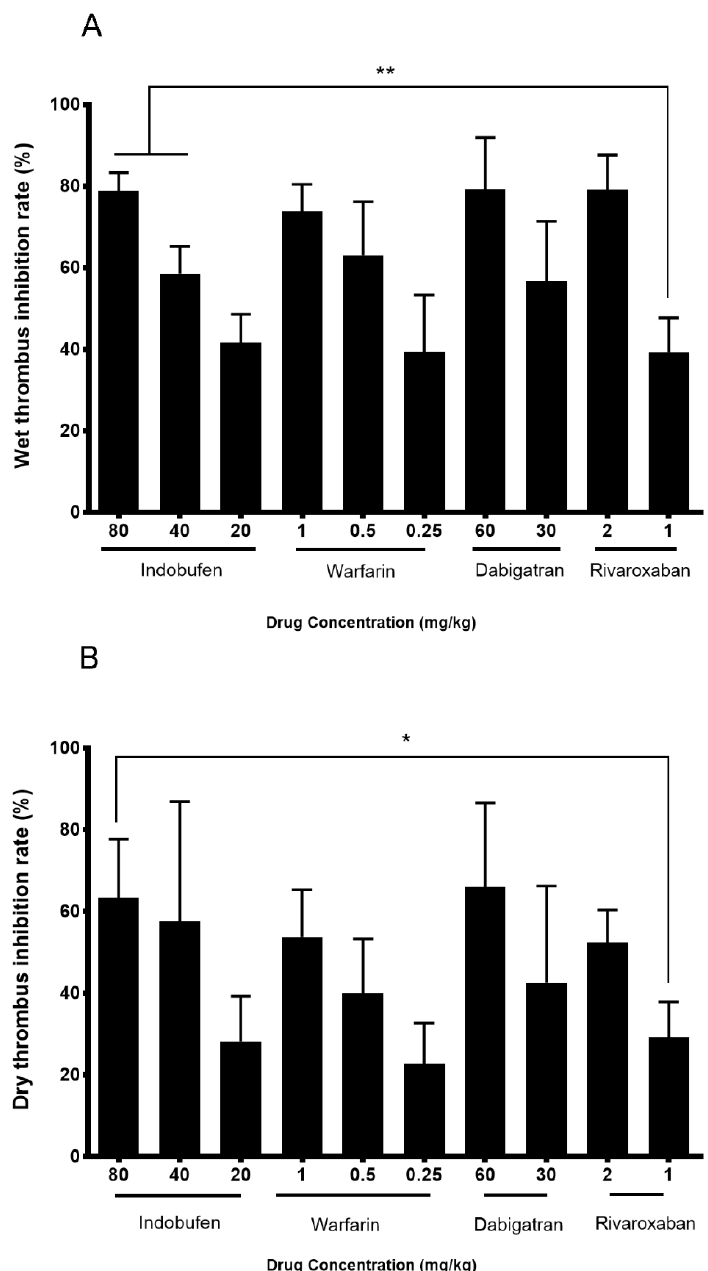
Figure 5. The effects of indobufen on thrombosis formation in a rat model of an arteriovenous shunt. ( A ) The results of wet thrombus inhibition. ( B ) The results of dry thrombus inhibition. * p < 0.05, ** p < 0.01 versus the rivaroxaban 1 mg/kg group (mean ± S.D., n = 8).